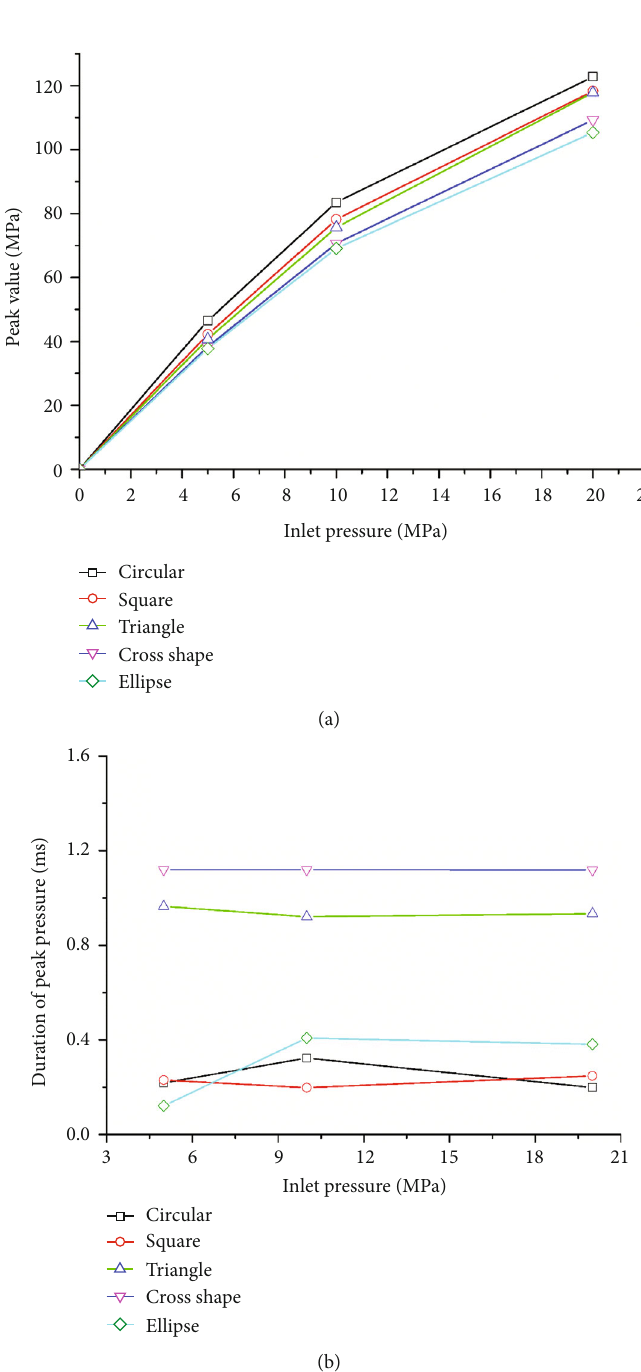
Figure 12: The relationship curve of peak pressure with jet inlet